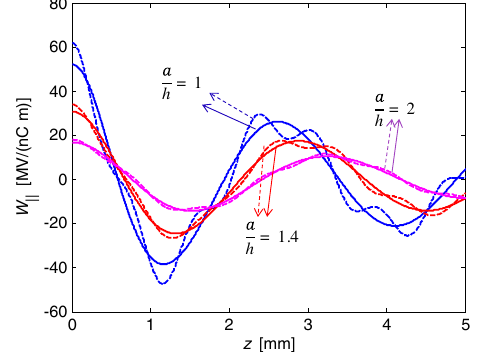
FIG. 6. Longitudinal wakefields without (solid line) and with (dashed line) the second band modes for different a with other nominal parameters in Table I.